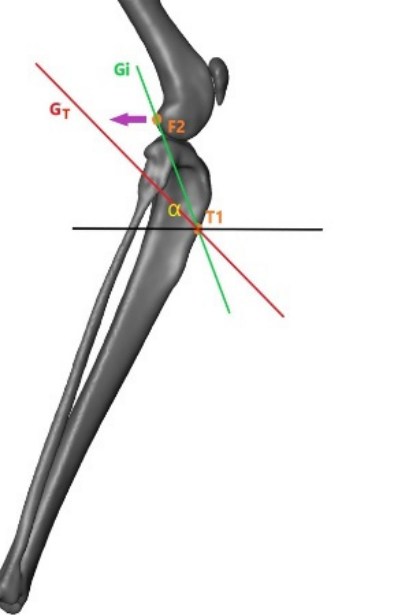
Figure 4. Illustration of the changes within the angle representing craniocaudal movement ( α ), showing that the angle becomes smaller after CrCL transection as the tibial crest (T1) is cranially displaced. α = measured angle; orange point T1 = point 1 cm distal to the tibial crest; orange point F2 = lateral aspect of lateral fabella in an intact CrCL; green line G i = vector between measured points with an intact CrCL; red line G T = vector between measured points with a transected CrCL; violet arrow = illustration of movement when the CrCL is transected. Scale bar indicates 10 mm.